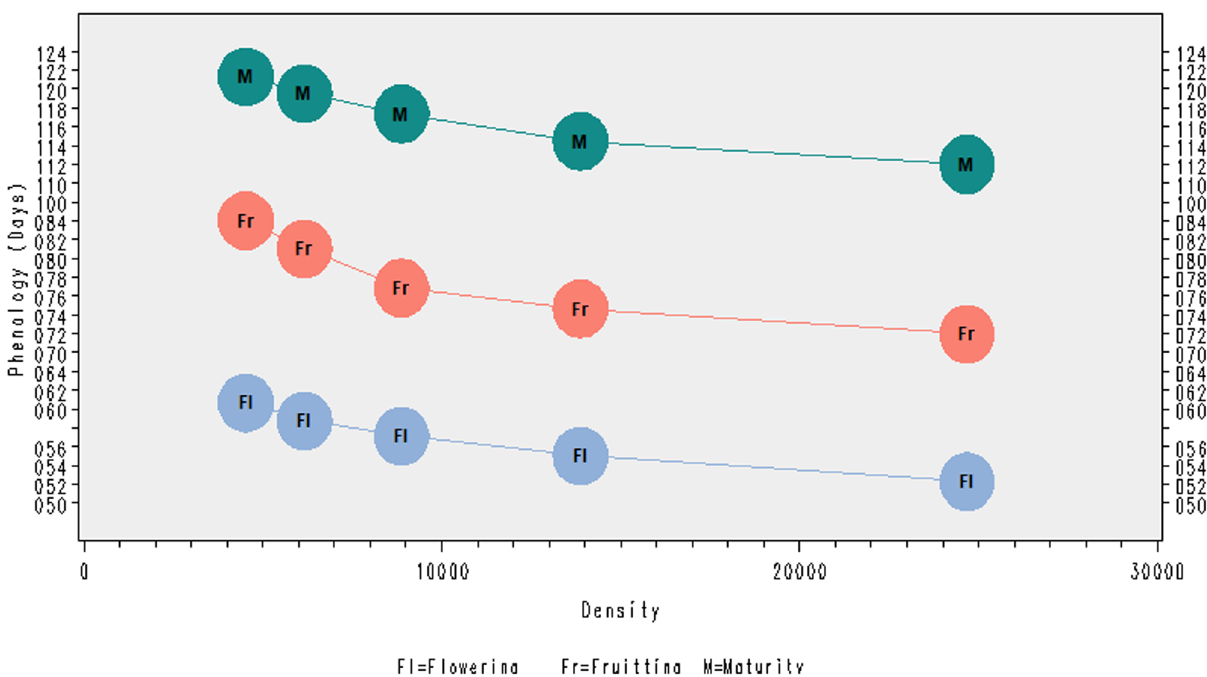
Figure 2: Phenological traits as a ff ected by plant density of